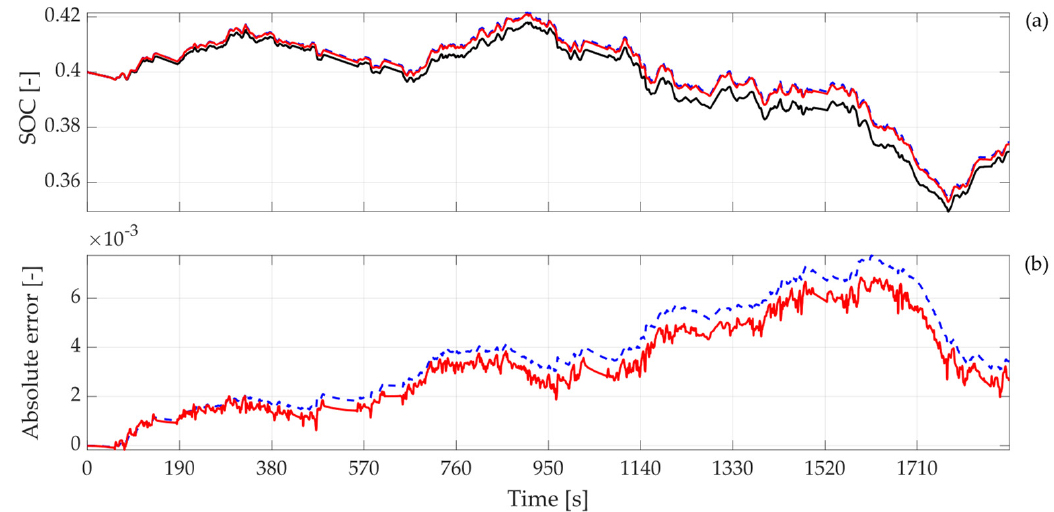
Figure 14. Results on testing dataset B—NARX RNN layout 2: ( a ) reference SOC (solid black line) vs. simulation estimated SOC (solid red line), HIL estimated SOC (blue dashed line) ( b ) absolute simulation error (solid red line), HIL absolute error (blue dashed line).